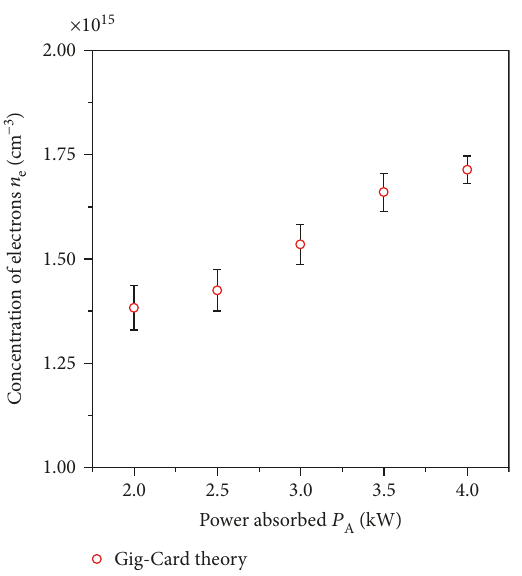
Figure 7: The concentration of electrons as a function of absorbed microwave power P A